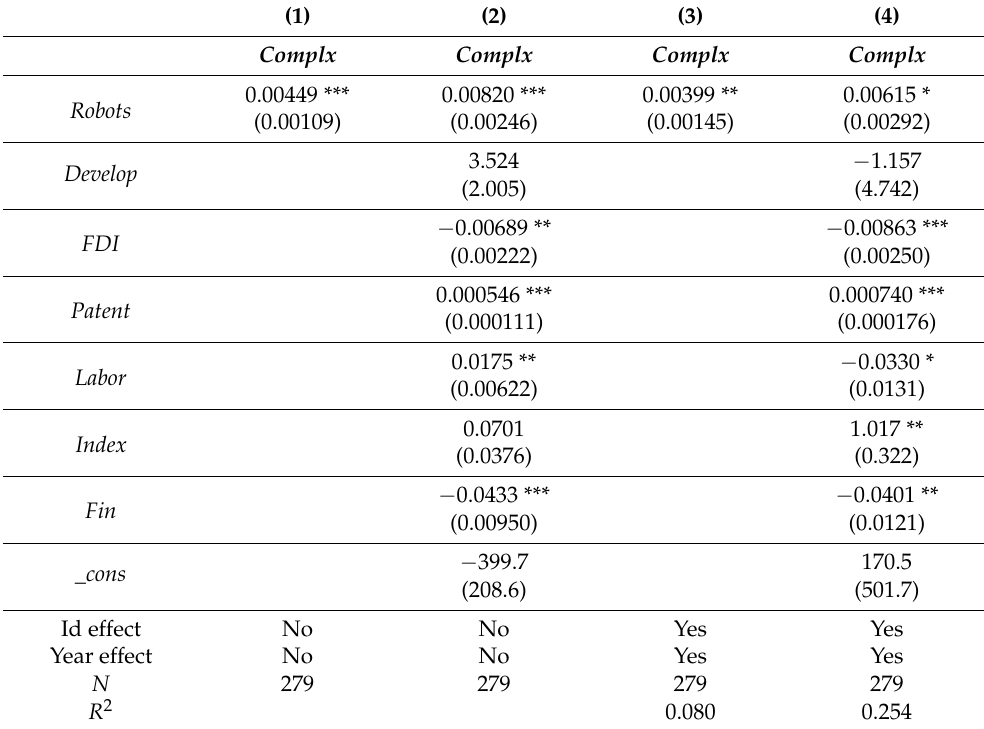
Table 3. Regression results of the two-way fixed-effect